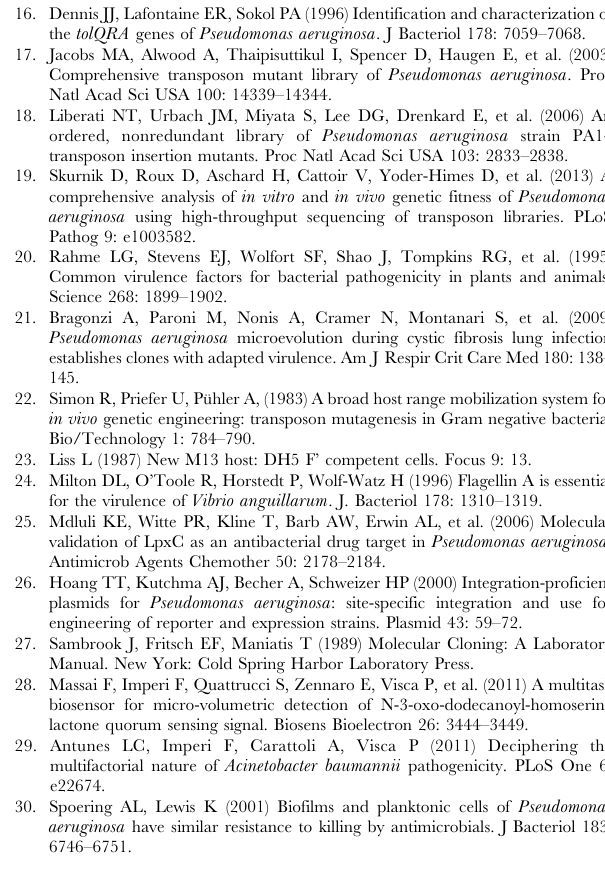
Figure S1 SEM and TEM images (left and right panels, respectively) of TolB-deficient mutant cells grown as described in the legend to Figure 3A. Bars: 1 m m (left panel) or 0.5 m m (right panel). Figure S2 Growth curves of the wild-type strain PAO1 (circles, solid lines) and the PAO1 tolB conditional